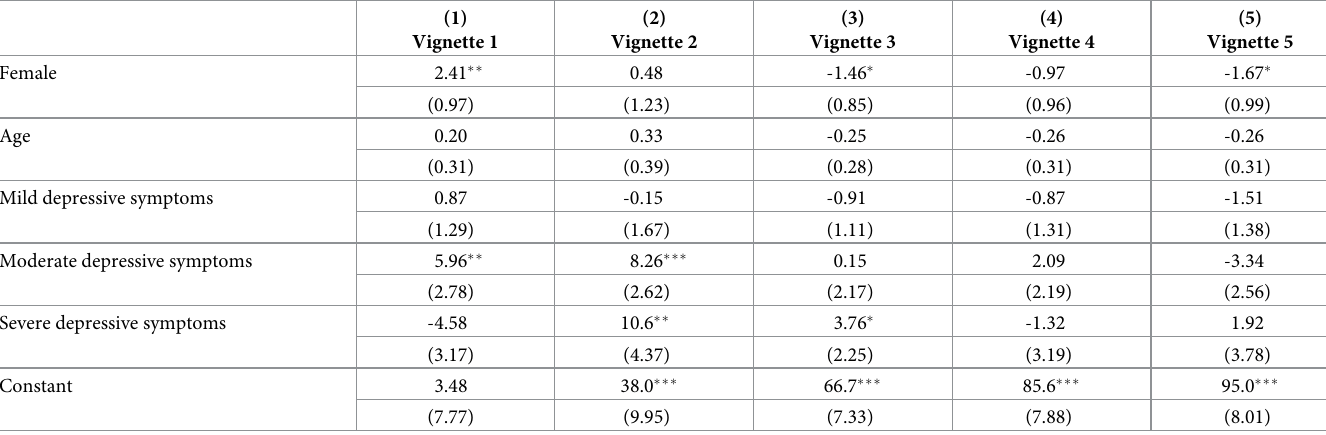
Table 3. Linear regressions of vignette evaluations on our set of control